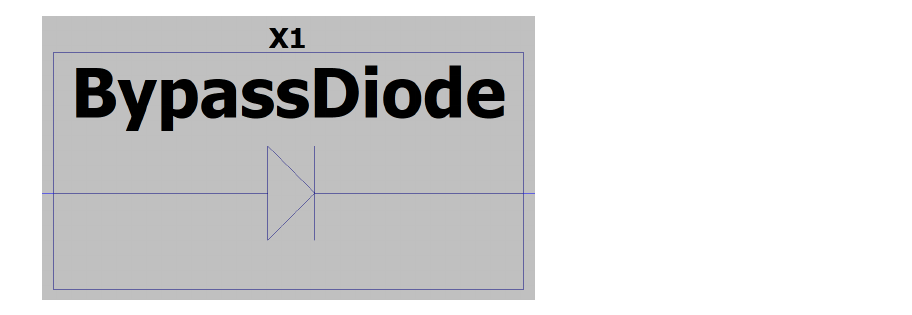
Figure 14. A custom symbol representing the LTspice implementation of the full circuital model from Figure 12. A sub-circuit representation allows for easier use within large simulations.